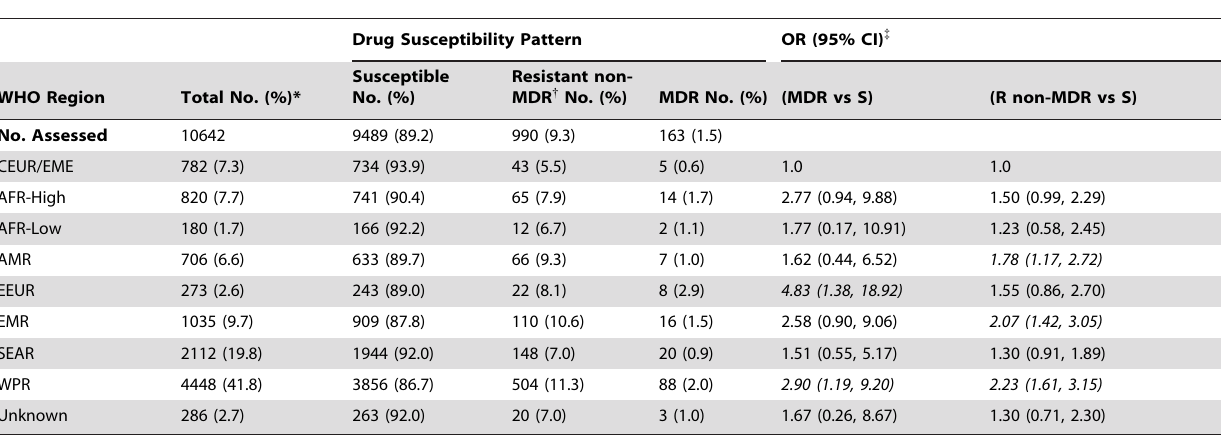
Table 2. WHO epidemiological region-of-birth of foreign-born culture-positive tuberculosis cases in Canada by drug susceptibility pattern of incident case isolate